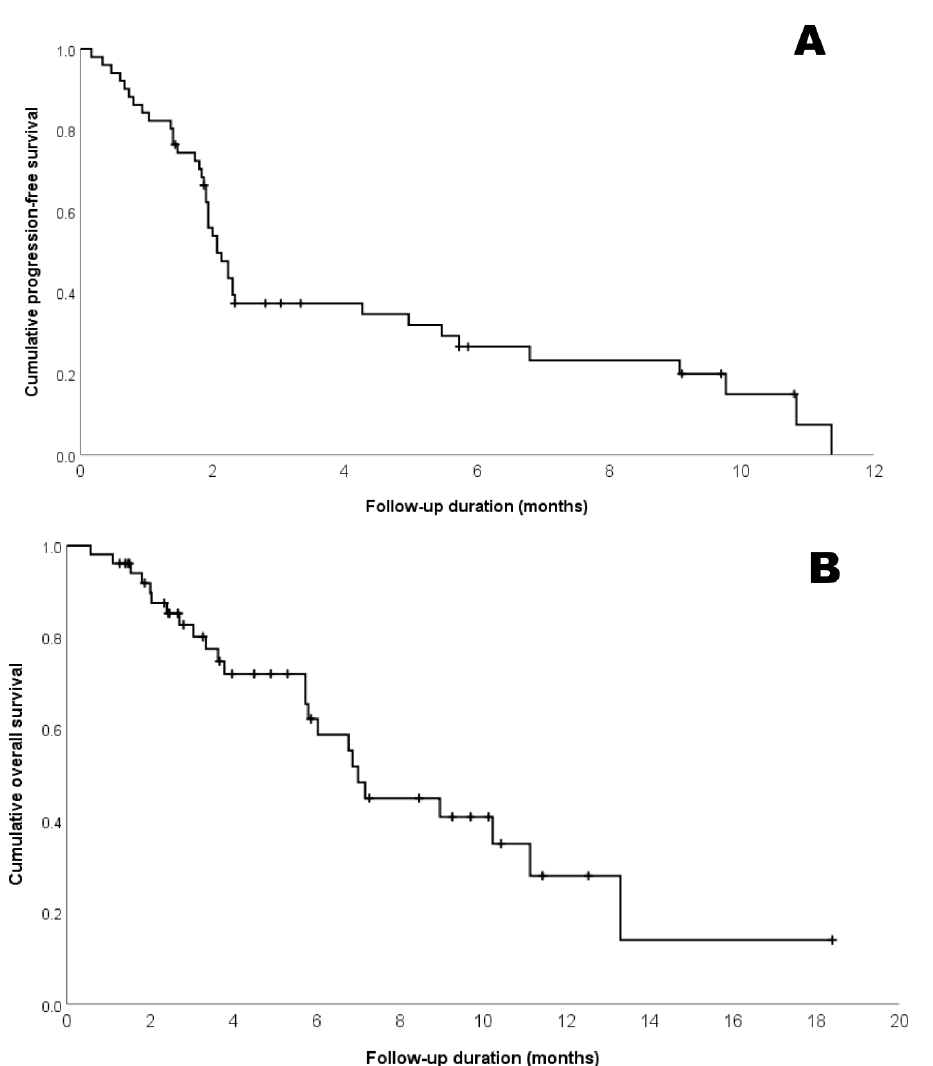
Figure 1. Kaplan-Meier estimates of the ( A ) progression-free survival (PFS); and ( B ) overall survival (OS) of the entire study population ( n = 51). Median PFS and OS were 2.1 (95% confidence interval (CI), 1.7–2.4) and 6.9 (95% CI, 5.4–8.3) months.